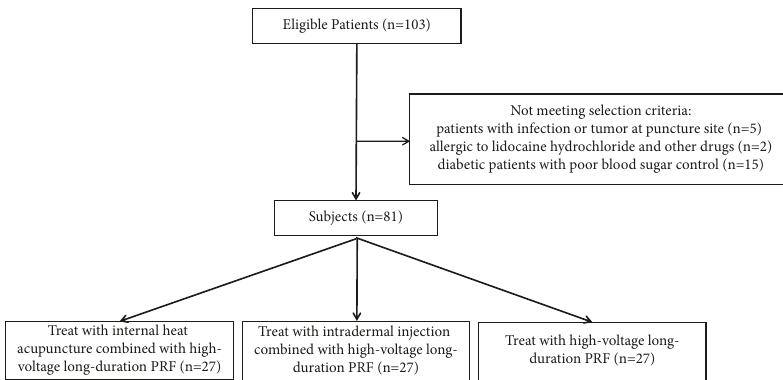
Figure 1: The study participants’ flow diagram.